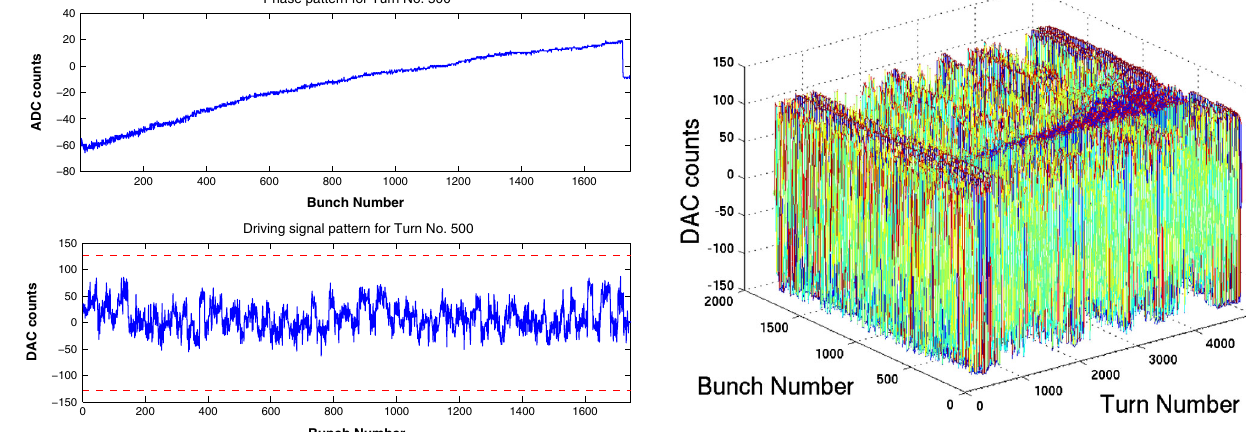
FIG. 7. (Color) HER front-end and back-end signals of the longitudinal feedback system for a single turn while the HER system is operating with nominal beam parameters at 1800 mA. The upper plot shows the phase error signal for all the bunches. The lower plot depicts the base band signal driving all the individual bunches at the same